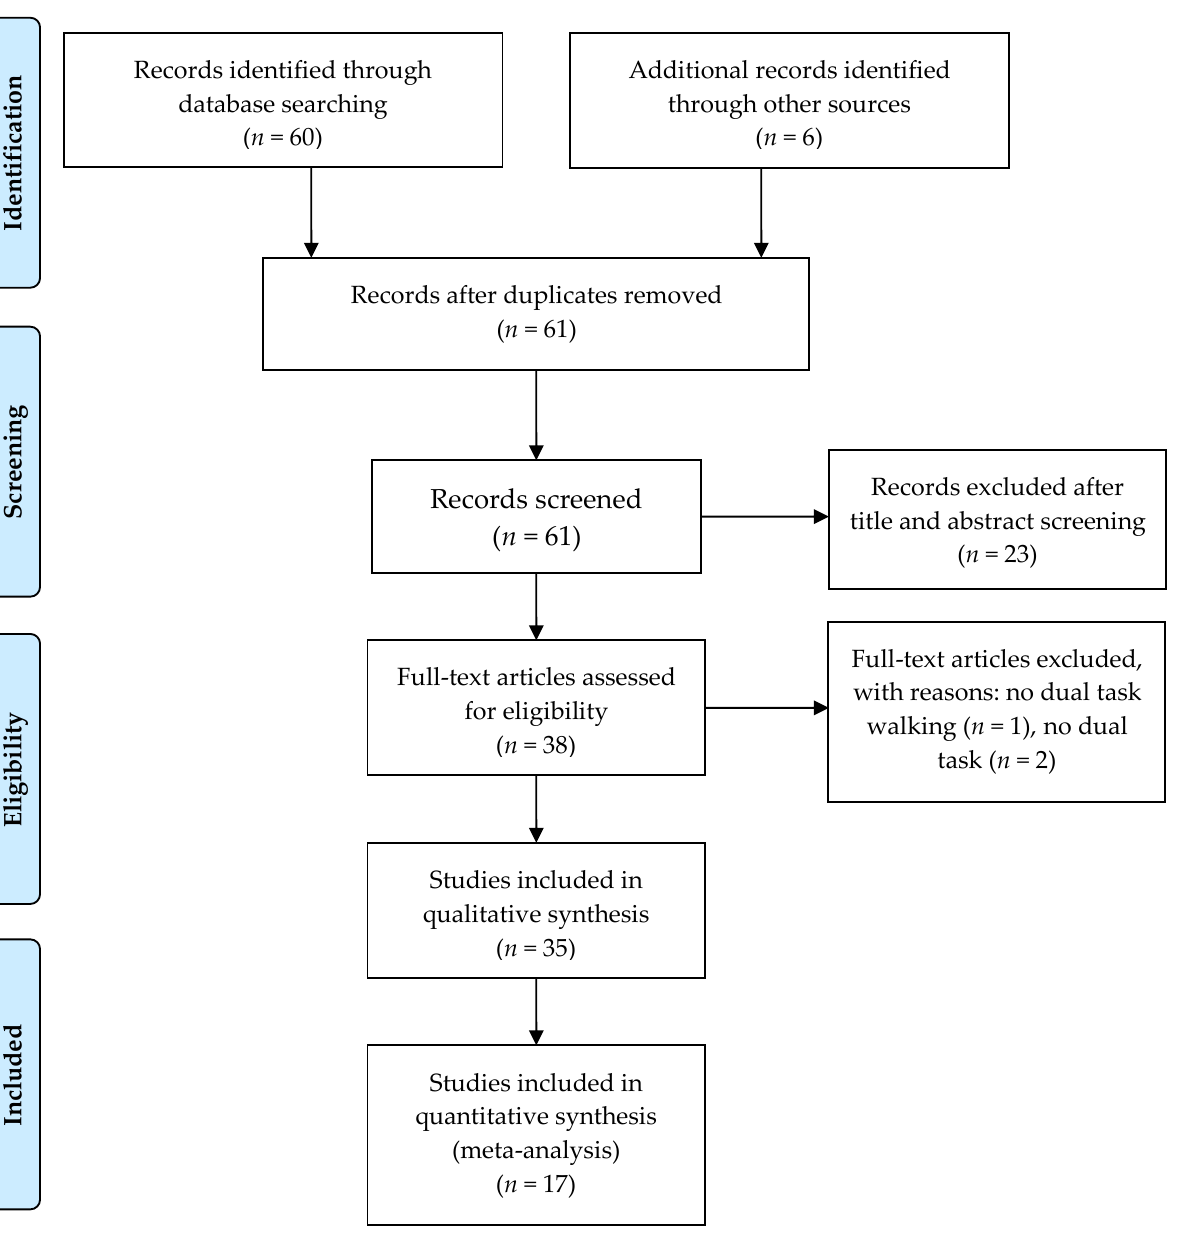
Figure 1. Systematic review PRISMA flow